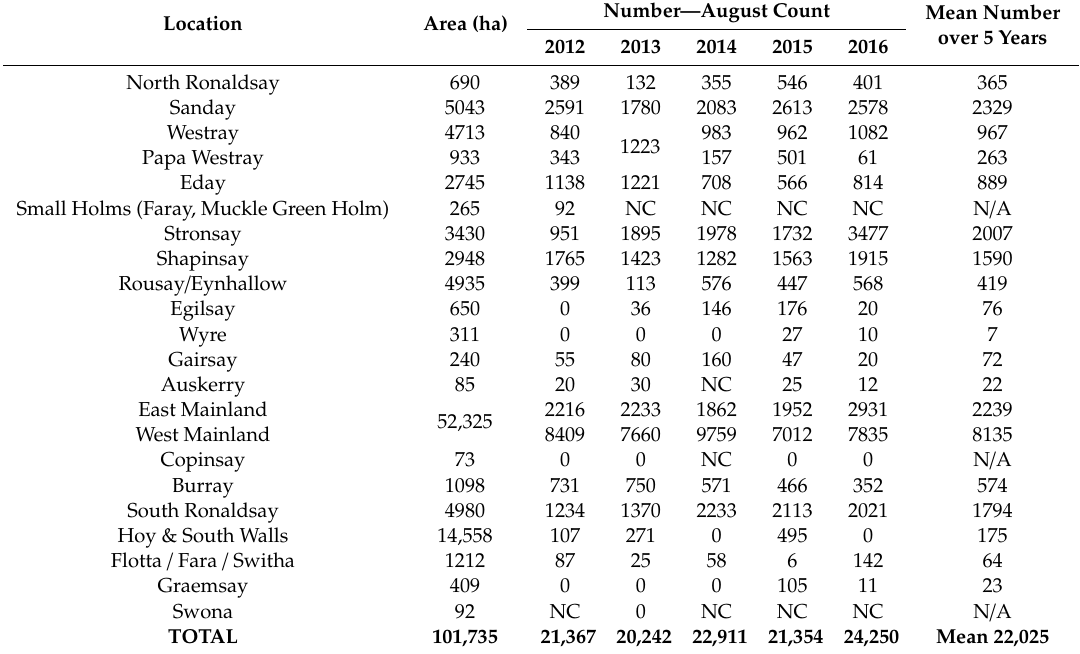
Table 1. Orkney Greylag geese counts for 2012 to 2016 for summer counts and Table 2. 2012 to 2018 for winter counts (data supplied by Scottish Natural Heritage). Summer (August) counts—resident population.